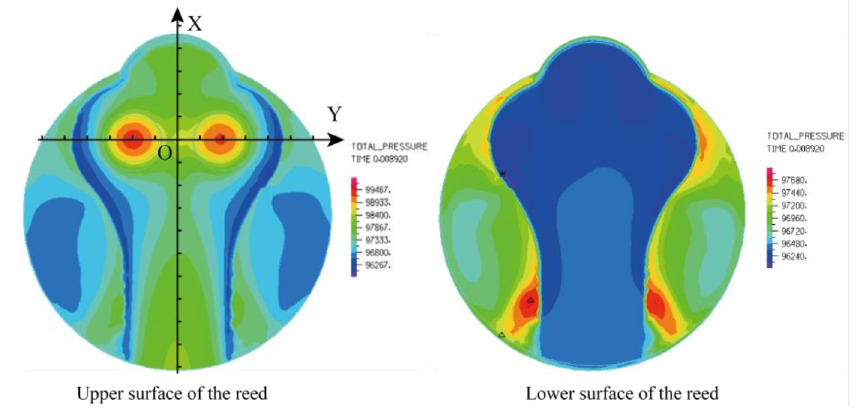
Figure 11. The pressure distribution on the lower and upper surface of the reed when the suction valve was opened.